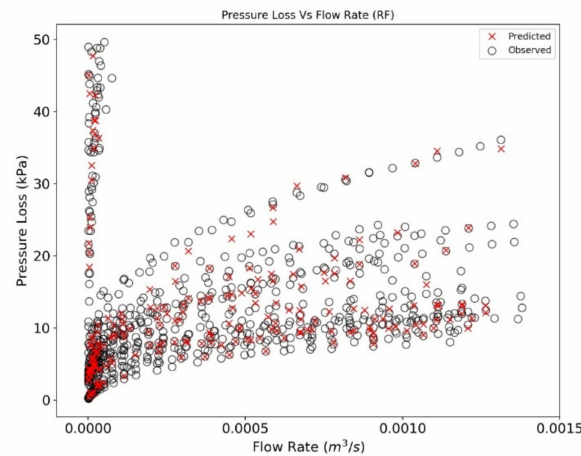
Figure 14. Observed and predicted pressure loss is plotted with flow rate for RF algorithm for low pressure